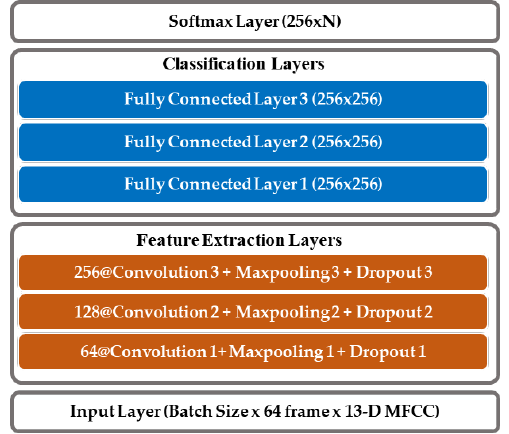
Figure 9. Layer configuration for the Convolutional Neural Network (CNN)-based LID.